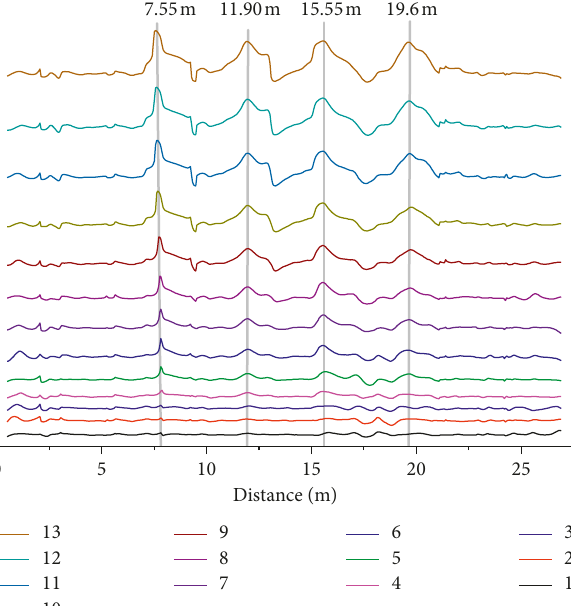
Figure 9: Results of 13 scans using BOFDA.